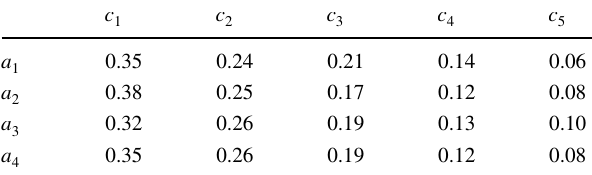
Table 8 Weights of the criteria